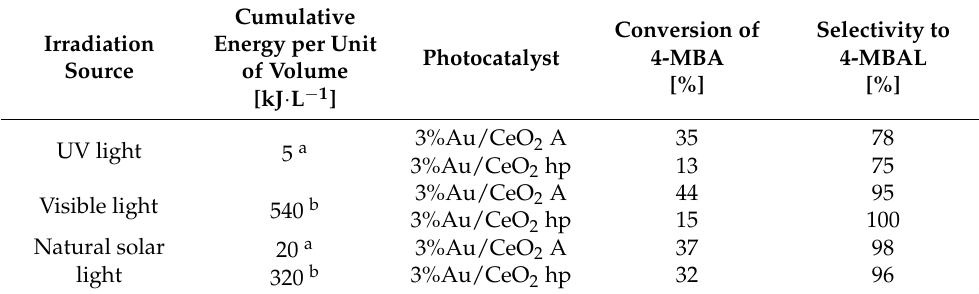
Table 5. Conversion percentage of 4-MBA and selectivity percentage towards 4-MBAL after 4 h of UV, visible or natural solar irradiation for runs carried out in the presence of 3%Au/CeO 2 A and 3%Au/CeO 2 hp as photocatalysts. Cumulative Conversion of Selectivity to Irradiation Energy per Unit Photocatalyst 4-MBA 4-MBAL Source of Volume [%] [%] [kJ · L − 1 ] 3%Au/CeO 2 A 35 78 UV light 5 a 3%Au/CeO 2 hp 13 75 3%Au/CeO 2 A 44 95 Visible light 3%Au/CeO 2 hp 15